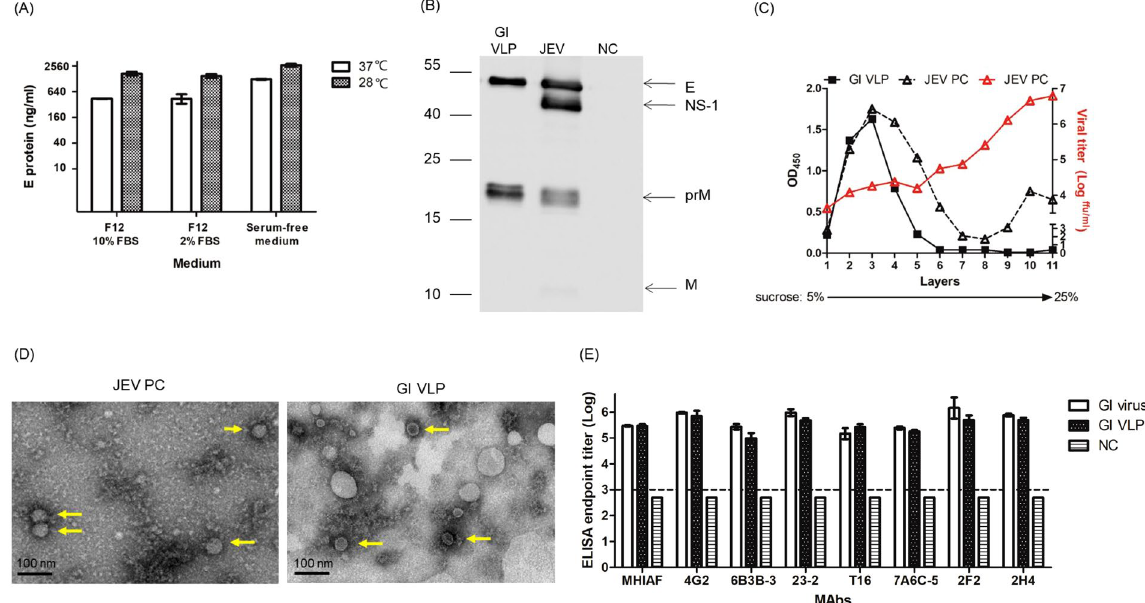
Figure 1. Characterization of the GI JEV VLPs produced from the stable 51-10 clone. ( A ) The yield of VLPs was determined in the supernatant of the 51-10 clone cultured in F12 medium supplemented with 2% or 10% FBS or in serum-free medium at 37 °C or 28 °C for 3 days by Ag-ELISA. ( B ) The secreted GI JEV VLP antigens collected from the supernatant of the 51-10 clone were analyzed by Western blot assay with anti-JEV HIAF and are indicated as GI VLPs. The supernatant collected from GI JE YL2009–4 virus-infected or the non-infected cells is presented as JEV or NC (negative control). Full-length Western blots are presented in Supplementary Fig. S2. ( C ) The GI YL2009-4 virus (JEV PC) and 51-10 clone-derived VLPs underwent ultracentrifugation in a gradient of 5% to 25% sucrose. The distribution of JEV protein ( Δ ) and infectious activity ( ) of JEV PC in the gradient was examined by Ag-ELISA and micro-plaque assay, respectively. The distribution of GI VLP particles ( ■ ) was detected by Ag-ELISA. ( D ) The morphology of purified GI JEV YL2009-4 virions (JEV PC) and GI VLP by staining with 2% uranyl acetate was analyzed by transmission electron microscopy. ( E ) The antigenicity of GI VLP was analyzed by Ag-ELISA with mouse anti-JEV HIAF (MHIAF) and flavivirus-reactive mAbs (4G2, 6B3B-3, 23-2, T16, 7A6C-5, 2F2, and 2H4). The supernatant collected from non-transfected CHO-HS(-) cells was used as the NC (negative control). The endpoint titers between GI virus and GI VLPs were run in duplicates and calculated by Student t test. Data are mean ±